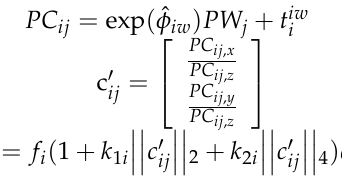
Algorithm 1: Bundle adjustment for motion